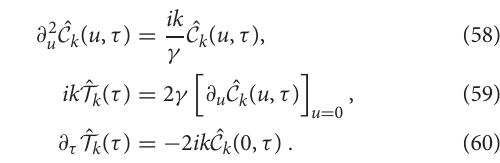
γ 1, T ℓ 1.1, T r 0.9 = = = =